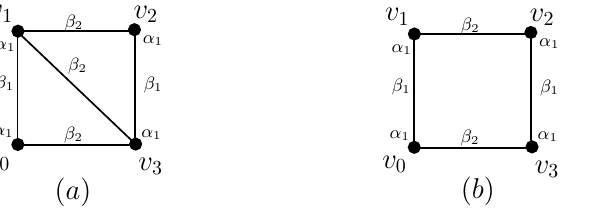
Figure 1. Graphs H and H − v 1 v 3 in Remark 1. A sharp example for the lower bound in Theorem